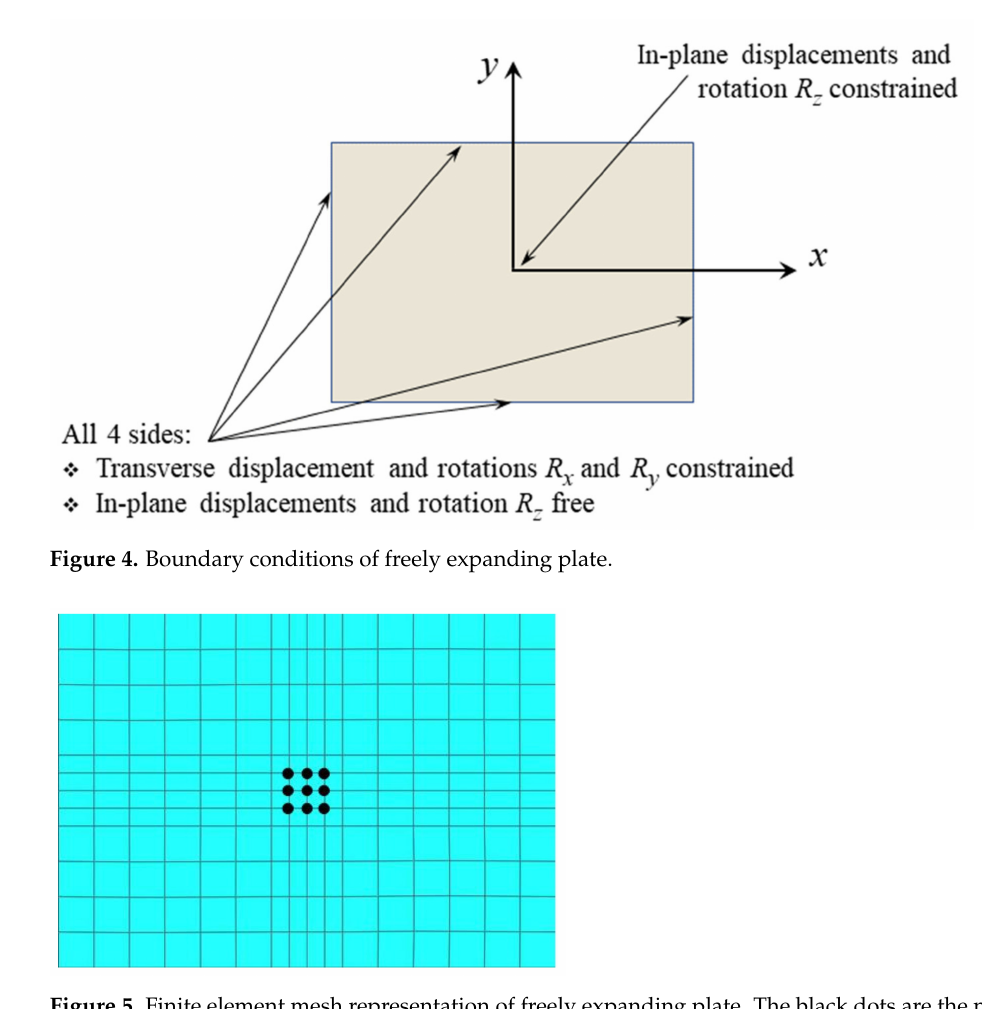
Figure 5. Finite element mesh representation of freely expanding plate. The black dots are the nodes at which the in-plane boundary conditions are imposed. Table 2. Dimensions and material properties of freely expanding